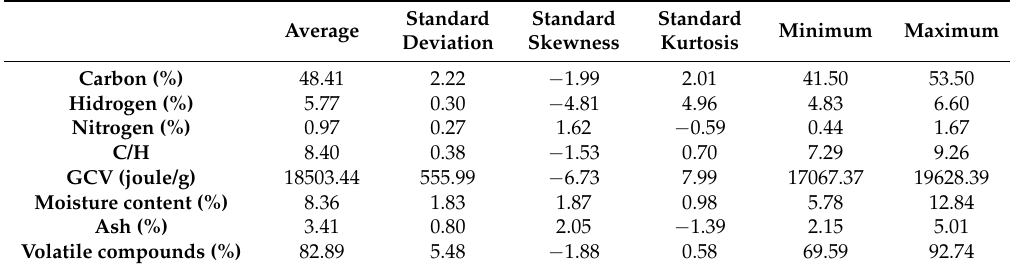
Table 2. Characterization of examined